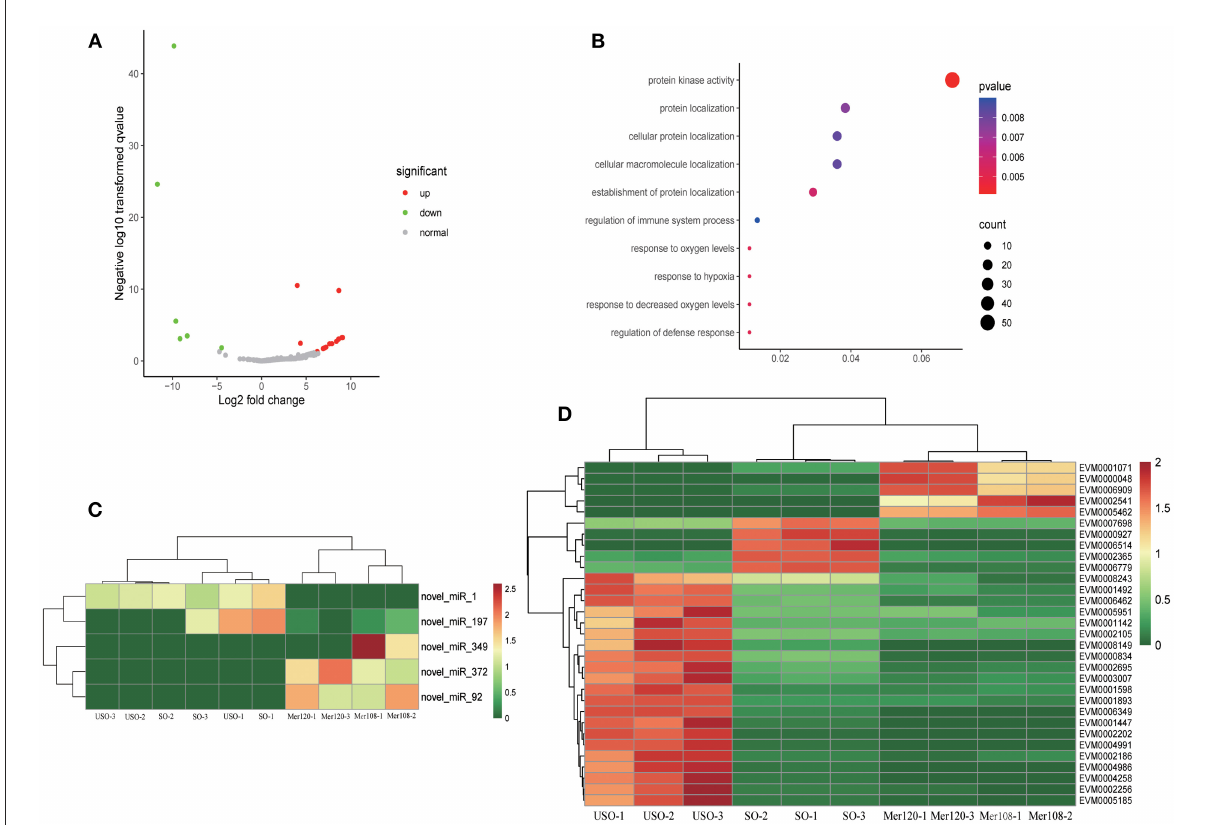
FIGURE3 Target gene analysis of differentially expressed miRNAs at exogenous and endogenous stages. (A) Volcano plot showing differentially expressed miRNAs between endogenous developmental stages (Mer108 and Mer120) and exogenous stages (USO and SO). Gray dots represent non-differentially expressed miRNAs, red dots represent up-regulated miRNAs, and green dots represent down-regulated miRNAs. |log2 (FC) | ≥ 1.00 and FDR ≤ 0.05 were regarded as statistically significant. (B) Go enrichment plot of differentially expressed miRNA-targeted genes in exogenous and endogenous stages. Only the 10 GO functions with the smallest p -value were taken for statistical purposes. (C) Heatmap showing differentially expressed miRNA-targeted genes enriched in the protein kinase activity pathway. (D) Heatmap showing differentially expressed miRNAs enriched in the protein kinase activity